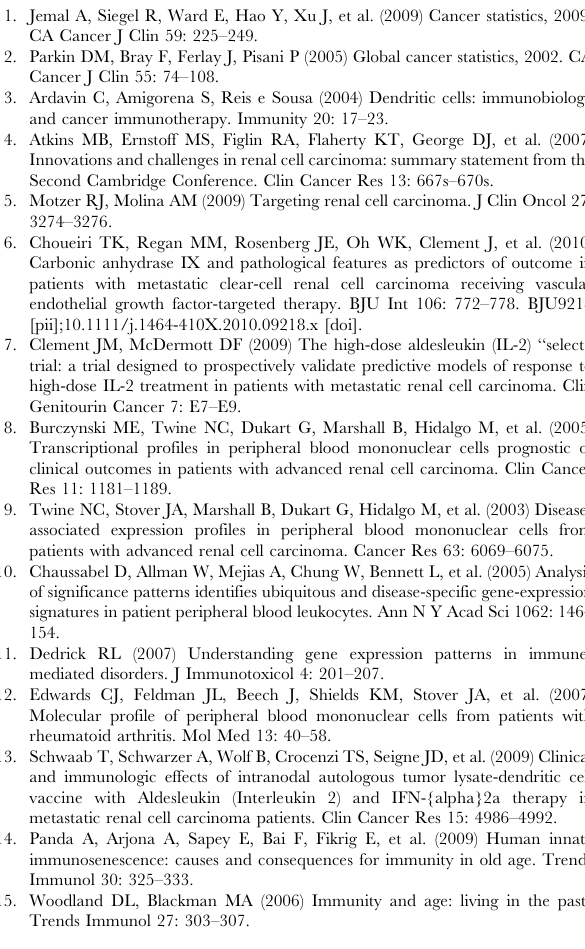
Table S1 Primer assays for RT-PCR. Table S2 Validation of index genes with RT-PCR. Differences in gene expression for patients vs. healthy controls as well as PRE vs. POST seen in microarray analysis could be confirmed with RT-PCR. Negative fold changes in microarray analysis as seen on the right side for PRE vs. POST correlate to corresponding RT-PCR fold changes. Two methods of fold change calculation (difference vs. ratio) had to be taken into account. Same RNA specimens were used for microarray analysis and RT-PCR. A clear correlation between relative expression values in RT-PCR with microarray analysis could be shown for all tested